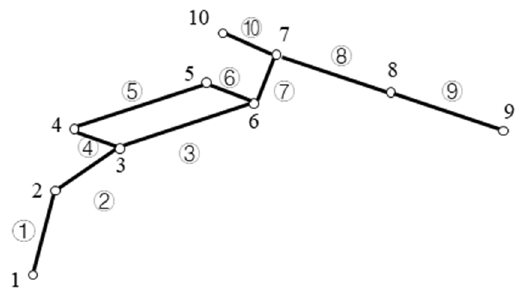
Figure 3. Structure of the robotic arm. 1–9 indicates the node numbers and ① – ⑨ the numbering of the beam units.